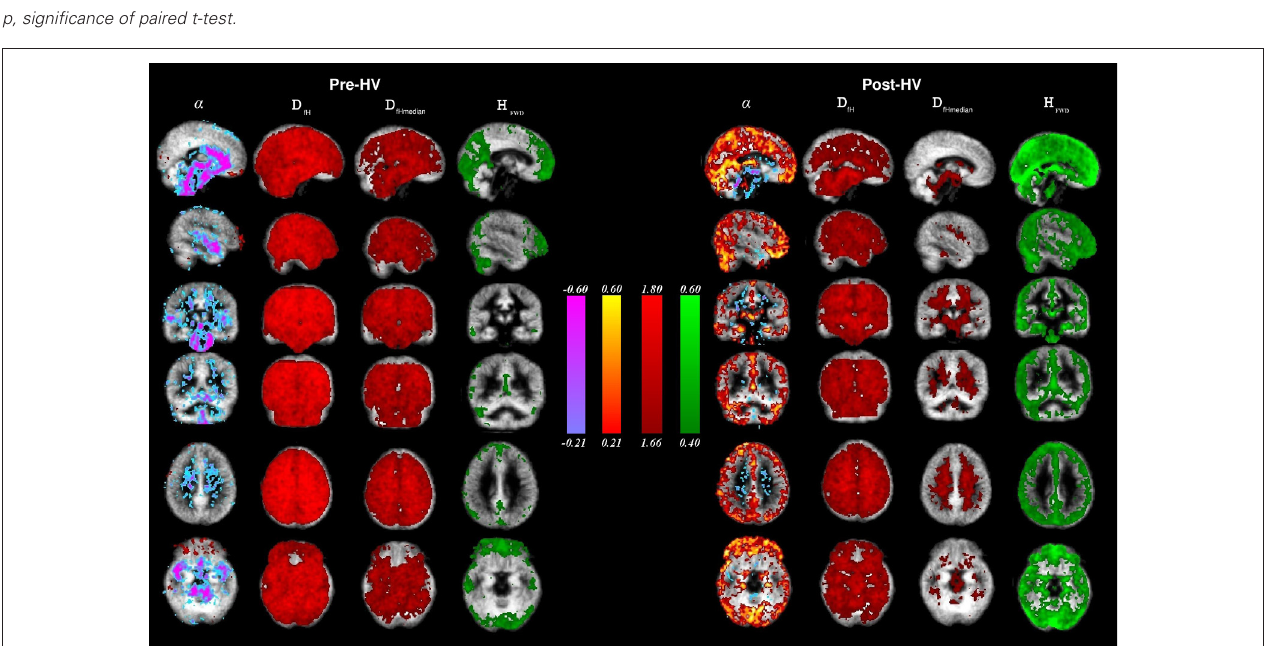
, and D (red) and H (green) in the brain during the state of normal ventilation ( Pre-HV , on the left) fH fHmeadian FWD